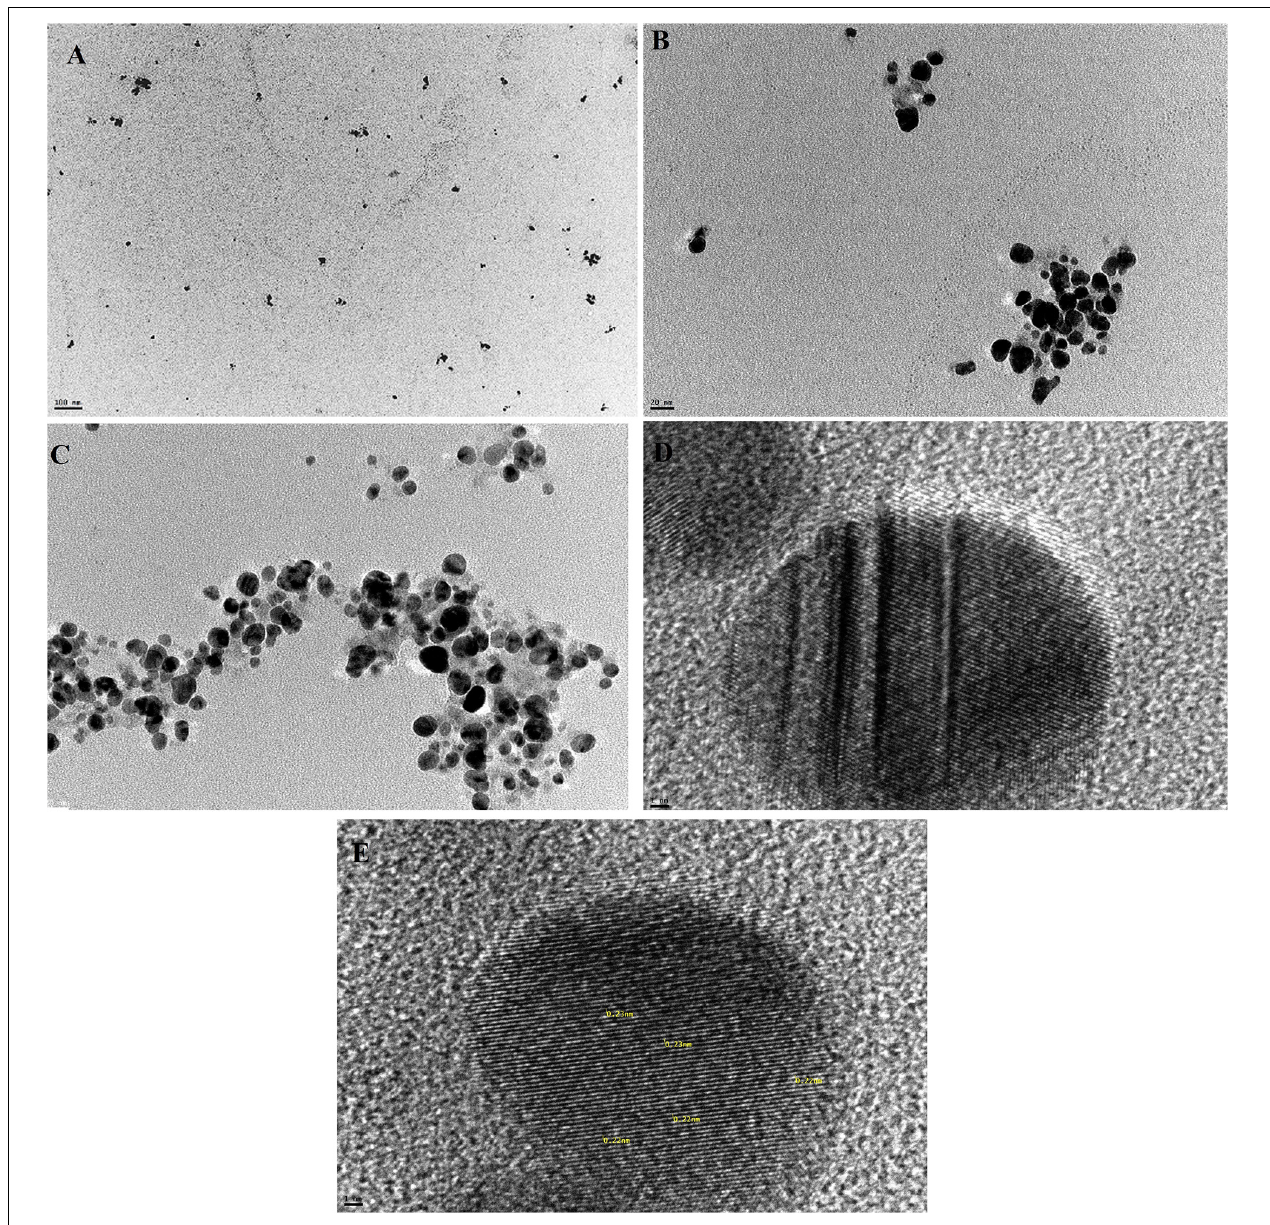
FIGURE 4 | Mycosynthesized AgNPs from A. terreus BA6 characterized by HRTEM (A) 70,000 × , (B) 500,000 × , (C) 500,000 × showing the coat around the particles, (D) 10,000,000 × showing the coat around the particles, and (E) 10,000,000 × showing the lattice planes inside the